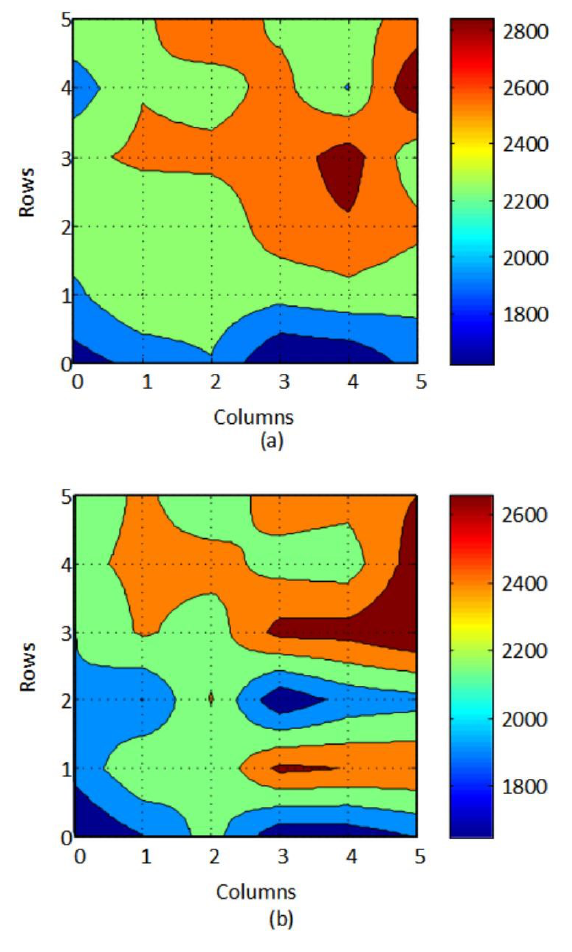
Fig. 9. Correlation